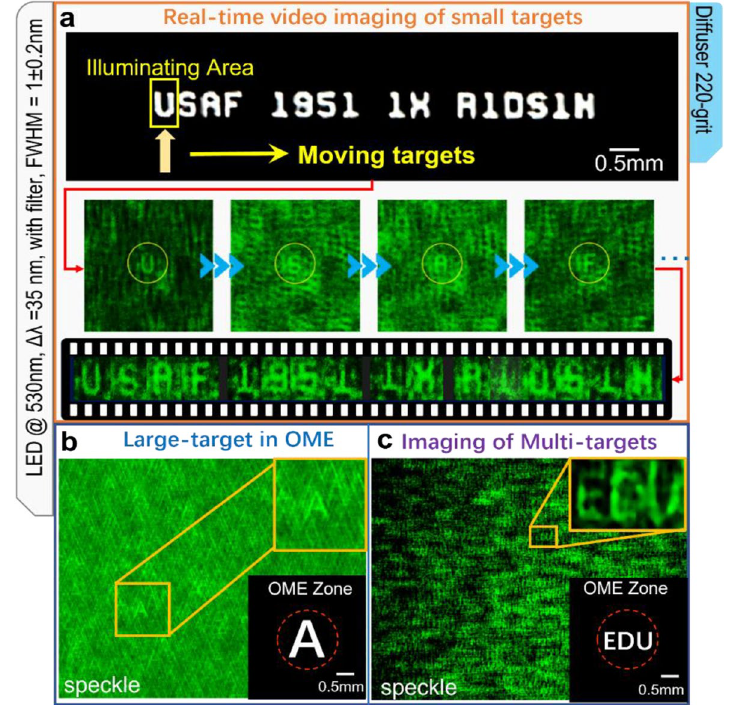
Fig. 4 Real-time video imaging through a diffuser. ( a ) Real-time imaging of moving objects through random diffusers. ( b ) Imaging of isolated object of letter ‘A’, and ( c ) multitargets of letters ‘EDU’. Clear self-imaging images of multitargets are observed directly and instantly. The insets in the lower right inset shows the object, in which the red-dashed circles depict the OME region. The upper right inset shows the observed self-imaging unit. Object-distance and image-distance are u